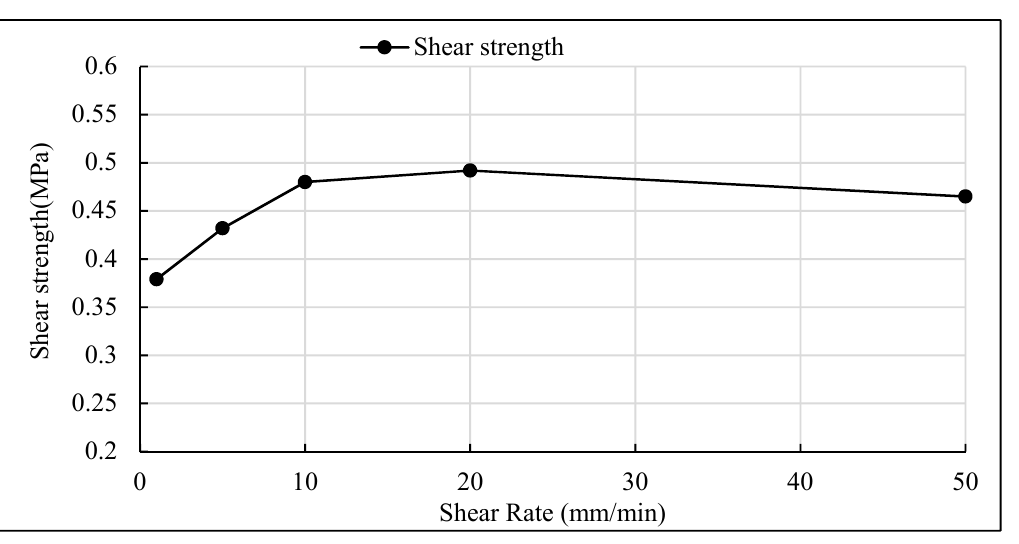
Figure 11. Relationship between shear rate and interlaminar shear strength.